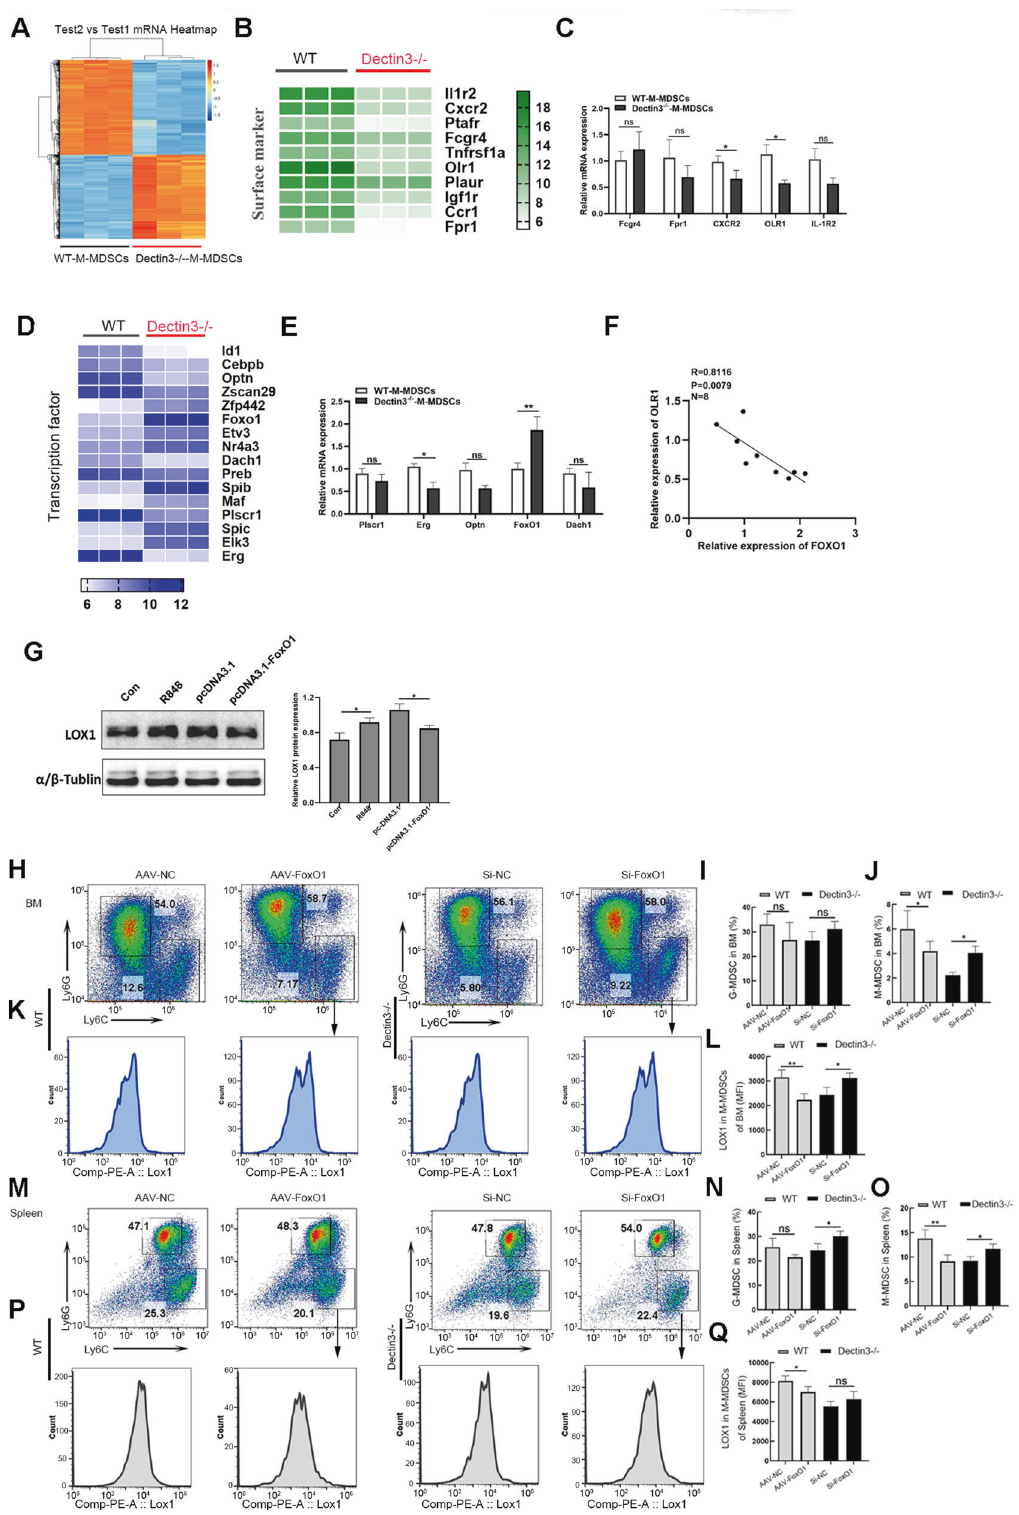
protein Bcl2 signi fi cantly decreased (Fig. 3D). The aforemen- tioned results indicated that Dectin3 regulated the number of MDSCs by regulating the nuclear transfer level of FoxO1. FoxO1 (Thr24, Ser256, and Ser319) was phosphorylated by Akt, which was transported from the nucleus to the cytoplasm, resulting